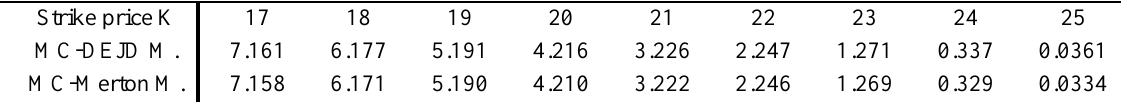
Table 5. Call option WHGS3 price values estimated by MC simulation under DEJD and Merton’s models. Strike price K MC-DEJD M. MC-Merton